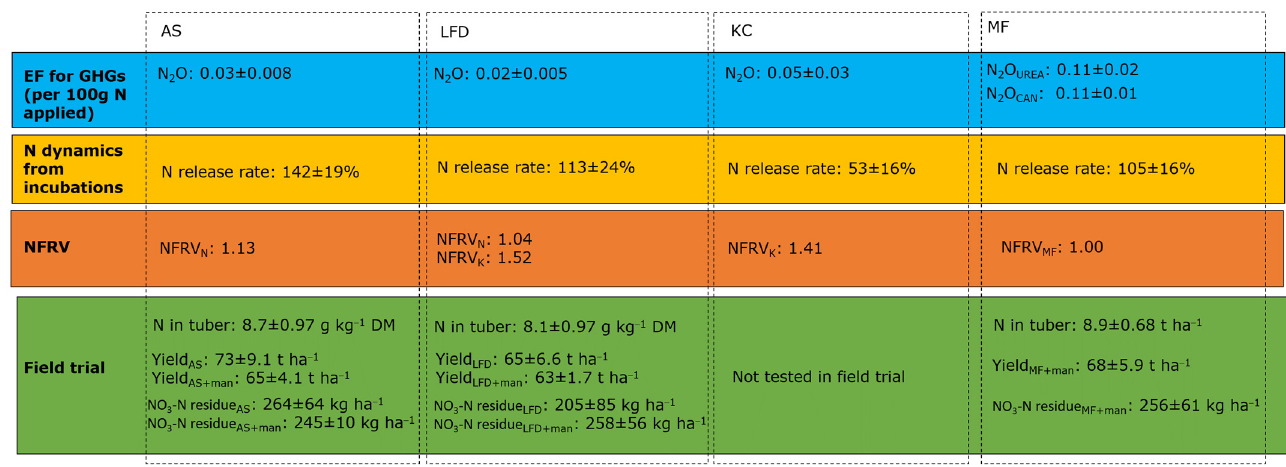
Figure 8. Summary of the results to compare refined bio-based fertilisers (ammonium sulphate (AS) and potassium concentrate solution (KC)) with less refined bio-based fertiliser (liquid fraction of digestate (LFD)) and mineral fertiliser (MF) with and without manure (man) on: (i) greenhouse gas (GHG) emission factor (EF) (blue), (ii) N release rate (yellow), (iii) nutrient fertiliser replacement value (NFRV), and (iv) potential field application